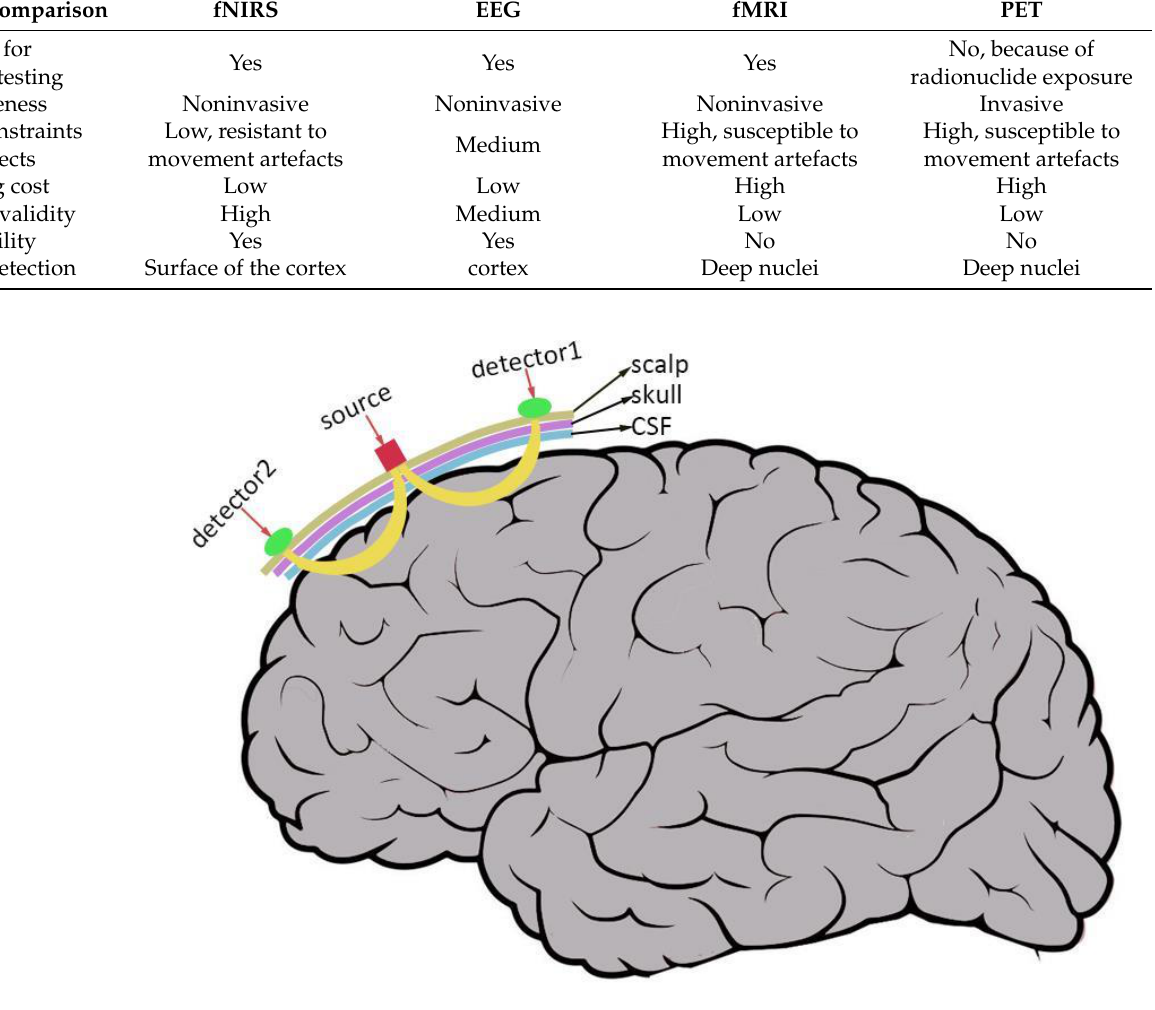
Figure 1. The general working principle of fNIRS: The light source (“source”) emits a mixture of near- infrared light wavelengths that are directed at the surface of the head. The photodetector (“detector”) on the scalp detects photons returning to the surface of the skull after taking a banana-shaped path (in yellow) in the tissues. The number and configuration of the detector and source on the head varies between studies. CSF stands for cerebrospinal fluid.